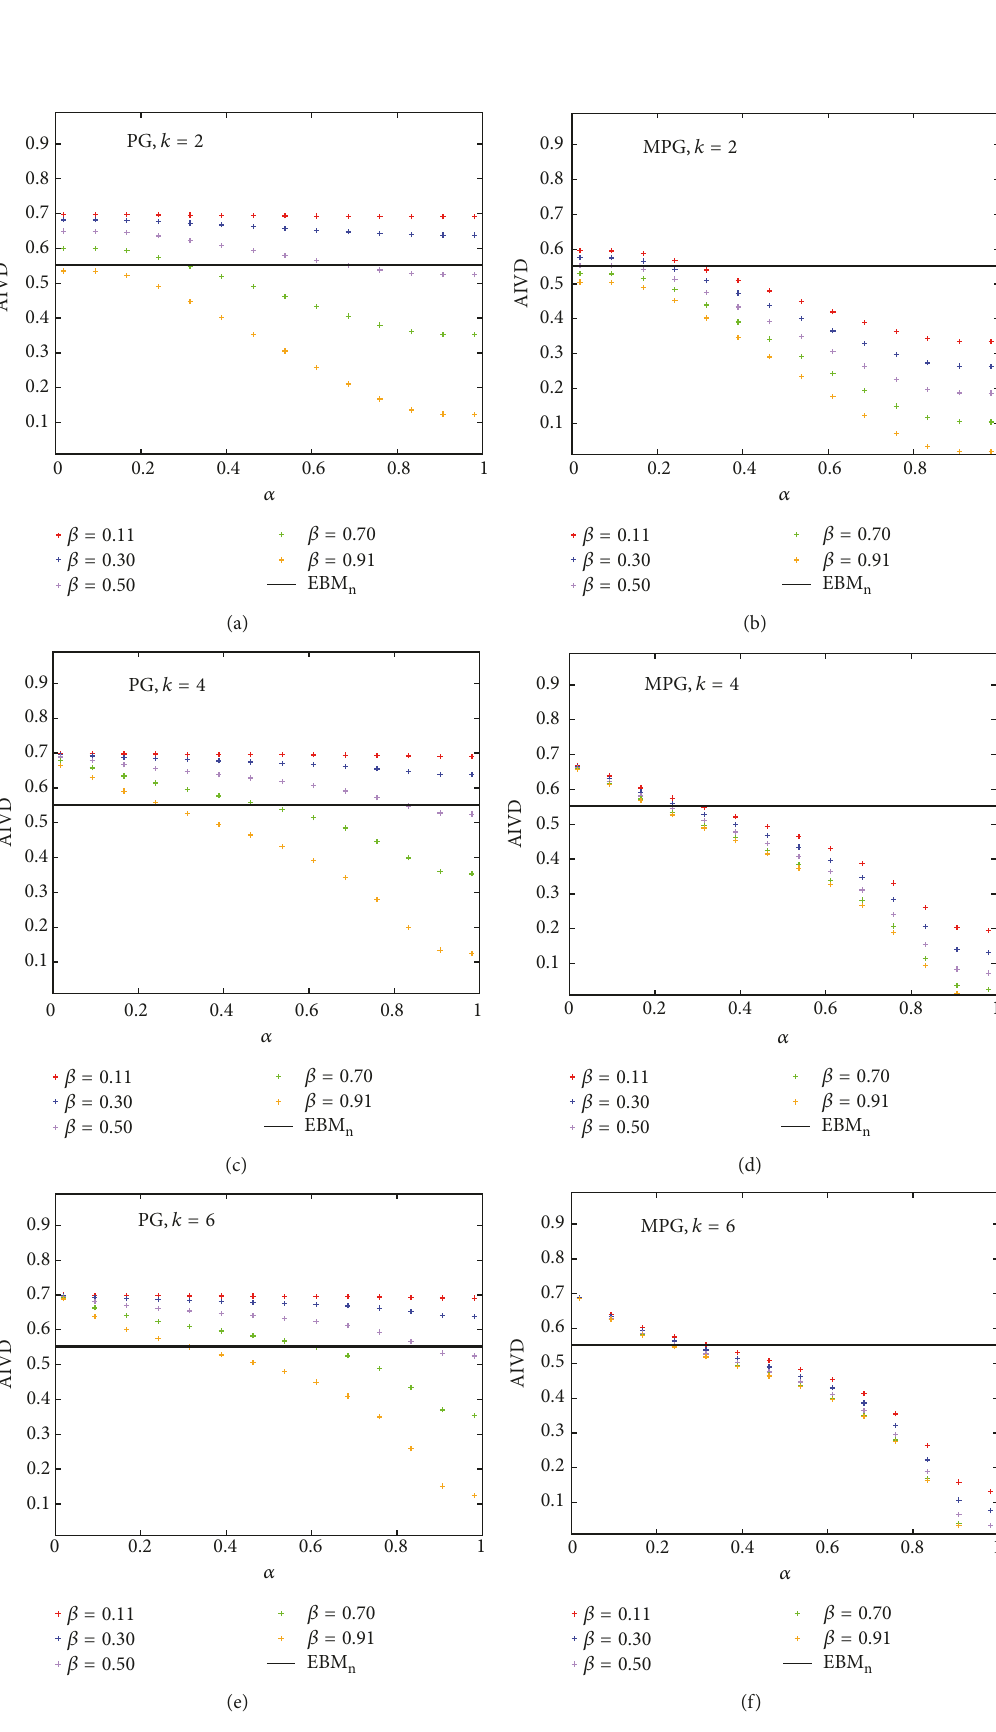
Figure 2: Dependence on model AIVD on the 𝛼 parameter, for several values of the 𝛽 parameter (legend), for 𝑘 = 2 (a, b), 𝑘 = 4 (c, d), and 𝑘 = 6 (e, f) prototypes, for the PG (a, c, e) and MPG (b, d, f) models. The horizontal lines show the empirical AIVD uncertainty range (one standard error on each side of the